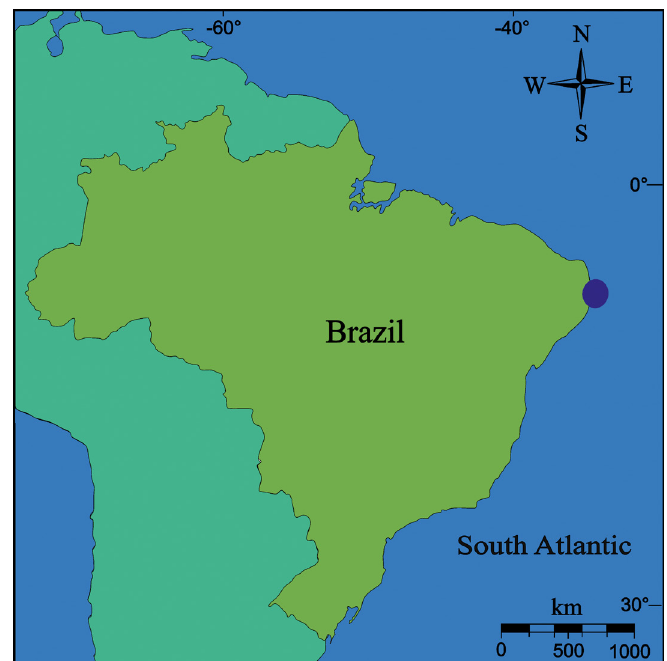
Figure 8. Distribution of Excorallana lemoscastroi sp. nov. for Brazilian